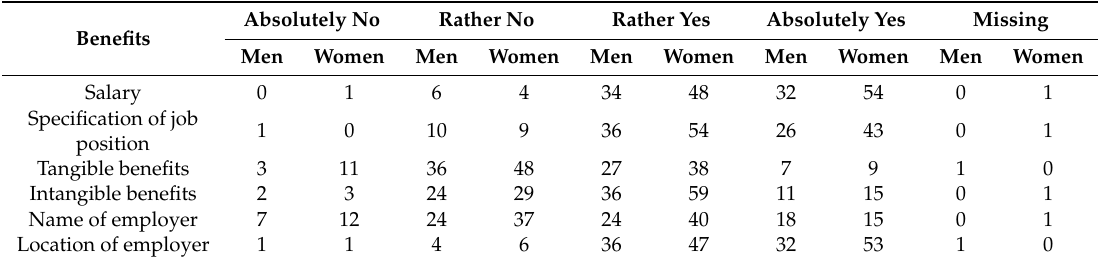
Table 3. Desirable benefits from applicant’s perspective according to gender.